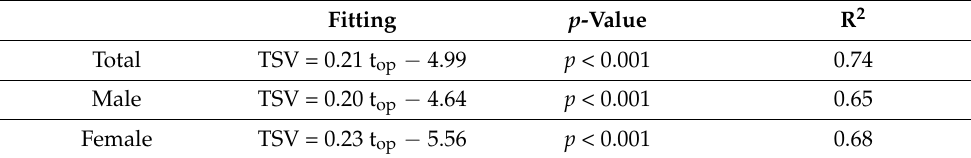
Figure 7. ( a ) TSV values reported by students versus T op ; ( b ) values of TSV reported by female and male students versus T op . Table 6. Fitting equations of TSV against t op . Table 6. Fitting equations of TSV against t op .